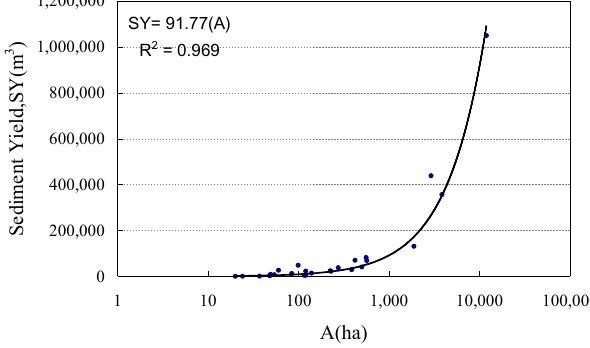
Figure 10. Relationship between sediment yield and watershed area for shallow landslide-prone